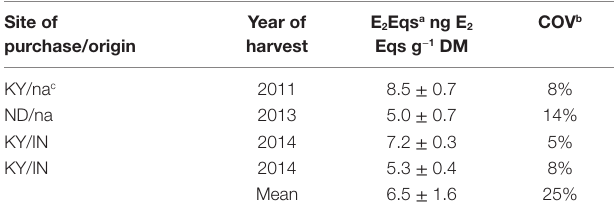
TaBle 1 | estrogenic equivalents of commercial soybean hull feedstuff by e-screen